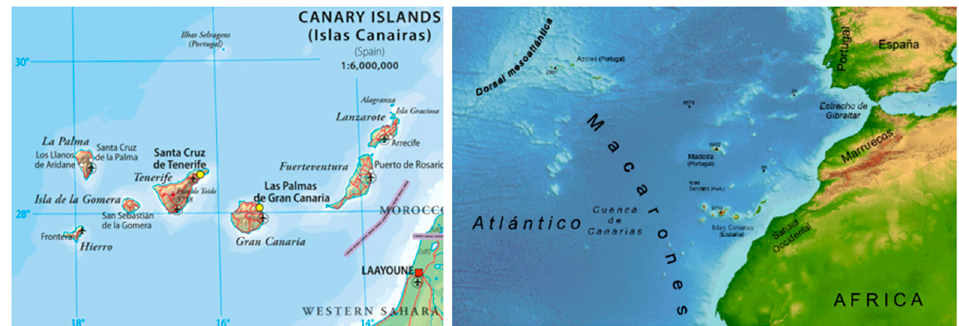
Figure 1. Canary Islands geographical location Map.